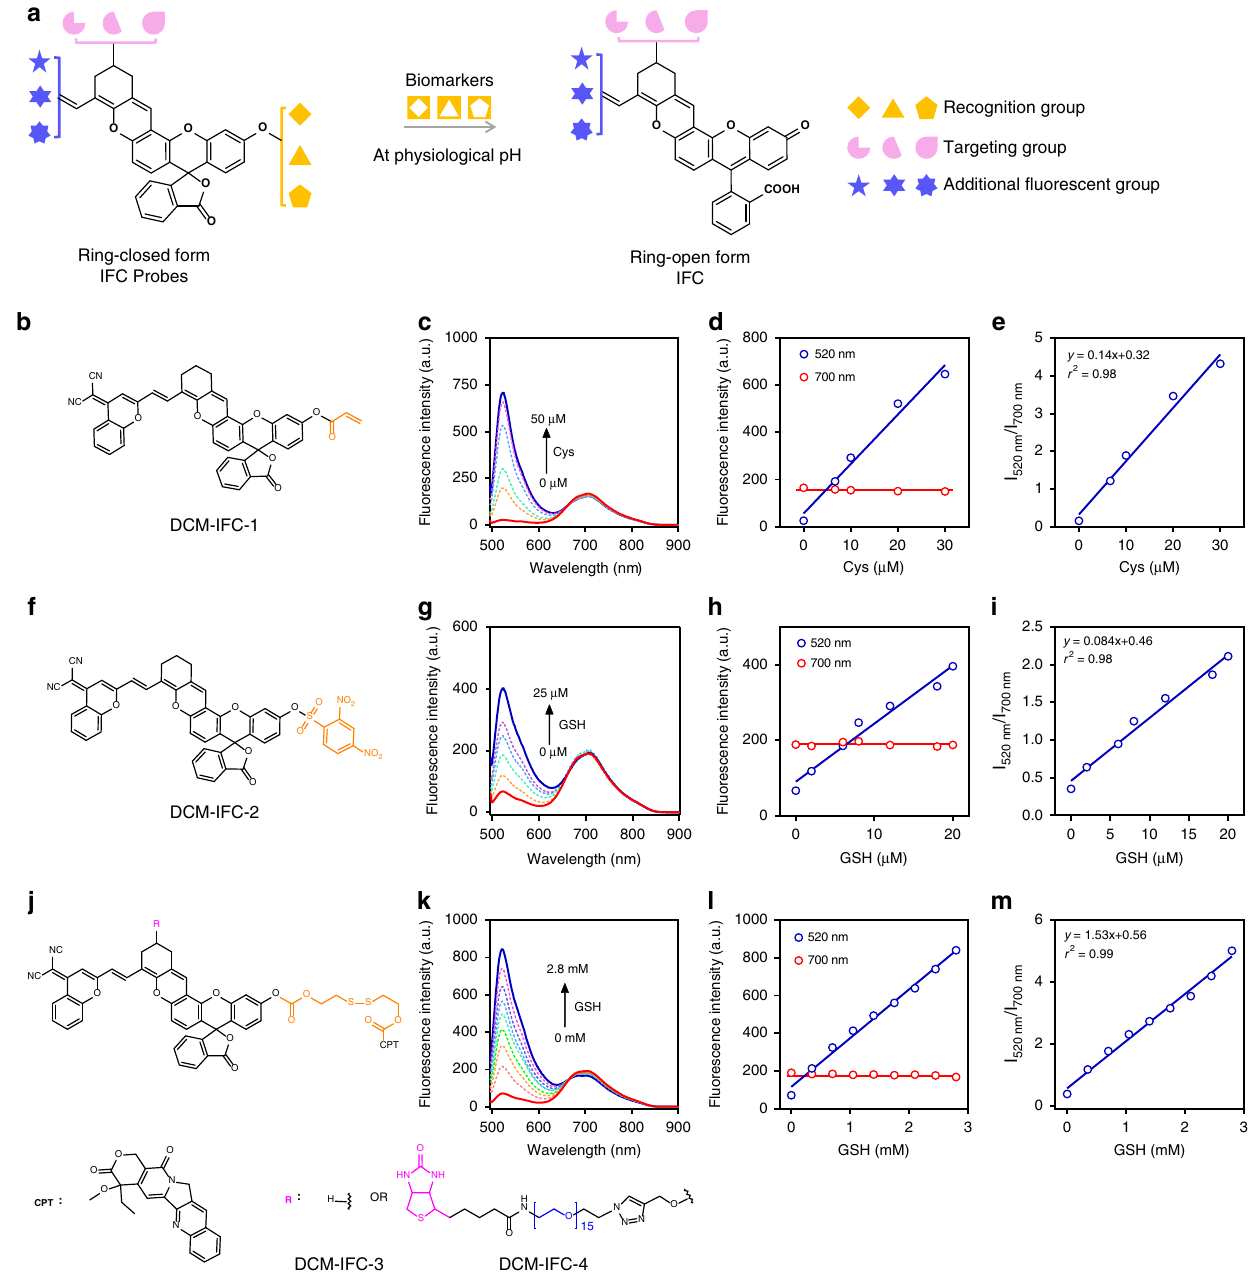
Fig. 5 A generalizable method for quantitative analysis with anti-Kasha-active chromophores. a Quantitative sensing platform. Chemical structures of DCM-IFC probes with different biomolecular-recognition groups: ( b ) acrylate group towards Cys; ( f ) 2,4-dinitrobenzenesulfonyl towards GSH; ( j ) disul fi de bond towards GSH, sense-and-release. Fluorescence spectra ( c , g , k ), ratiometric response with internal reference signal ( d , h , l , Source data are provided as a Source Data fi le.) and dual-channel linear ratio analysis ( e , i , m , Source data are provided as a Source Data fi le.) of DCM-IFC-1, DCM-IFC-2, DCM-IFC-3, and DCM-IFC-4 for various analytes. Note: all fl uorescence spectra were measured in a mixture solution of MeCN/phosphate-buffered saline (PBS, pH = 7.4), λ ex = 480